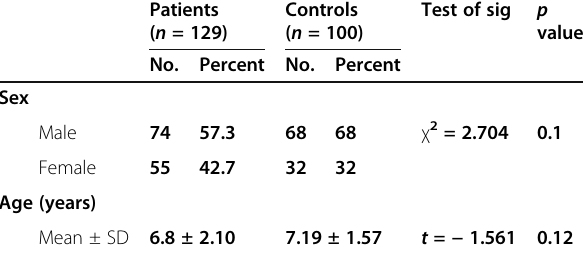
Table 3 Test – retest reliability of the SN-5 questionnaire at